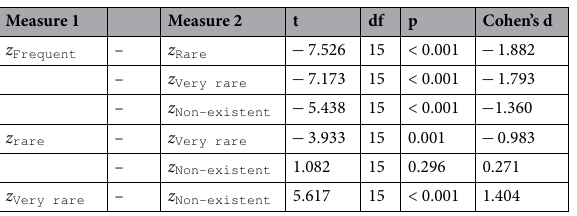
Table 5. Paired samples T-test on the values of z fitted per word type on the lexical classification dataset.